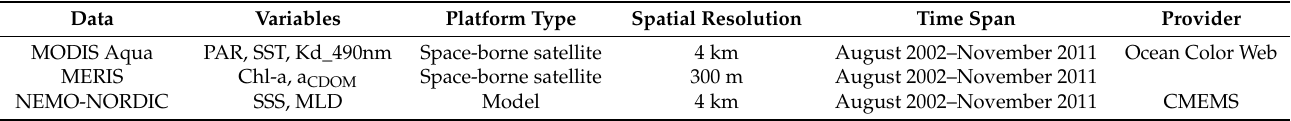
Table 1. Variables used to estimate partial pressure of carbon dioxide (pCO 2 ) in the study. Data